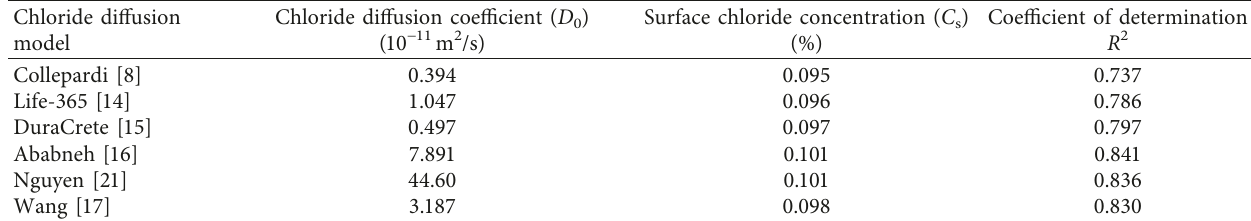
Table 3: Results of regression analysis with different chloride diffusion models.